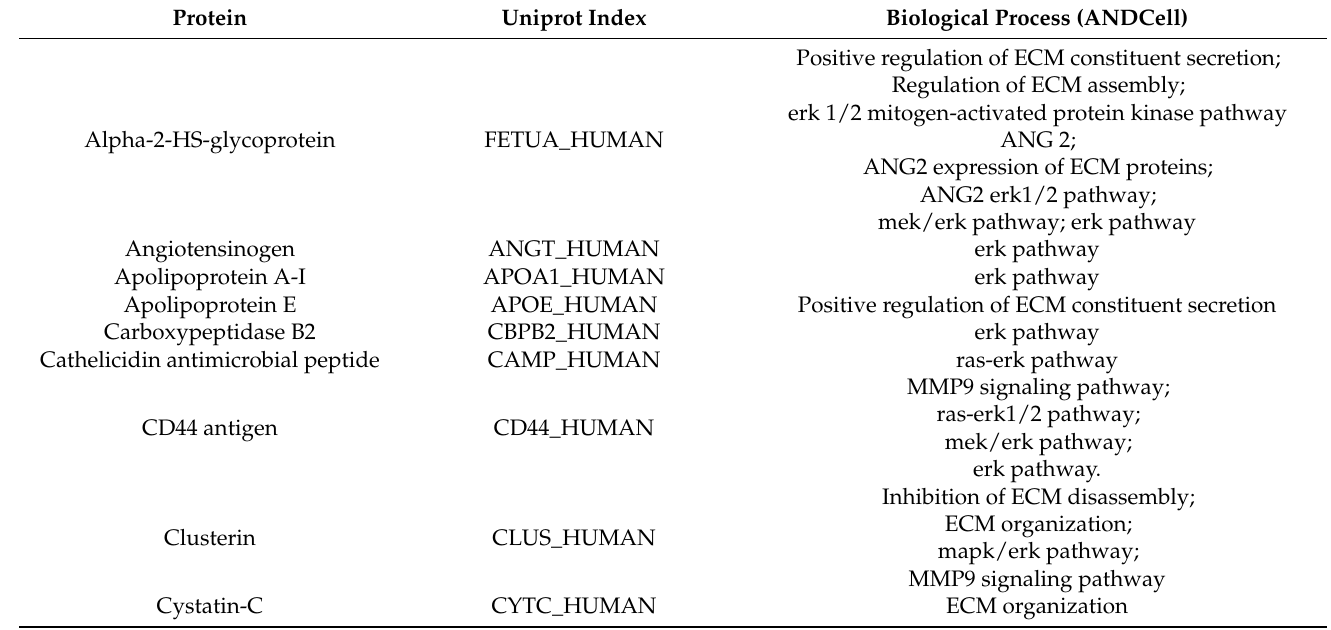
Table 2. Spaceflight factors-affected biological processes involving matrisome proteins.